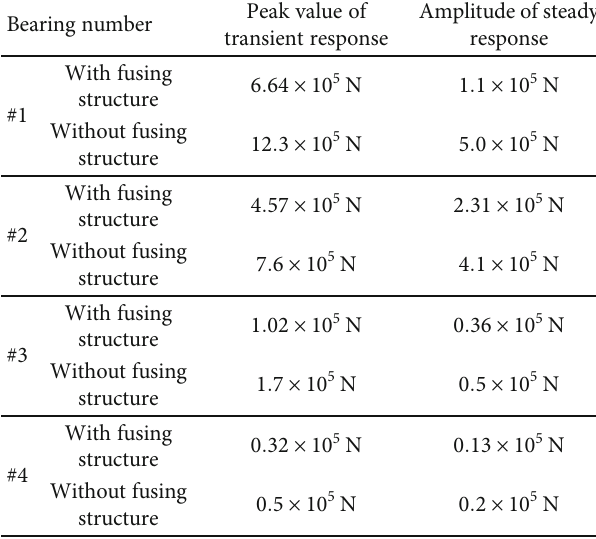
Table 7: Response value of a dual-rotor system with varied-sti ff ness fusing